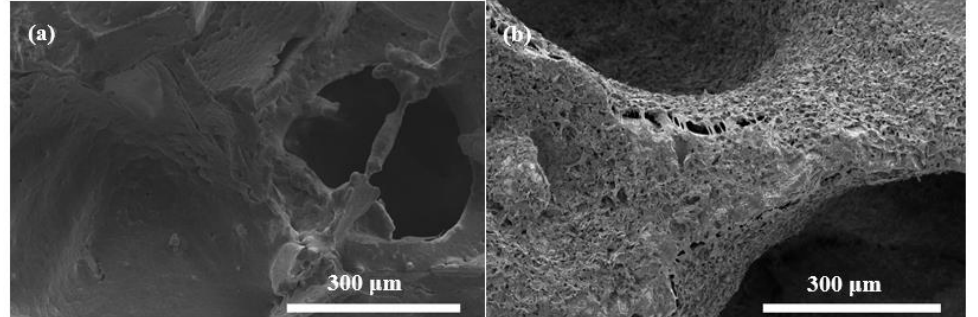
Figure 3. SEM micrographs of the ( a ) bare PCL-coated, ( b ) 10 wt% graphene-containing PCL-coated bioactive glass scaffolds.